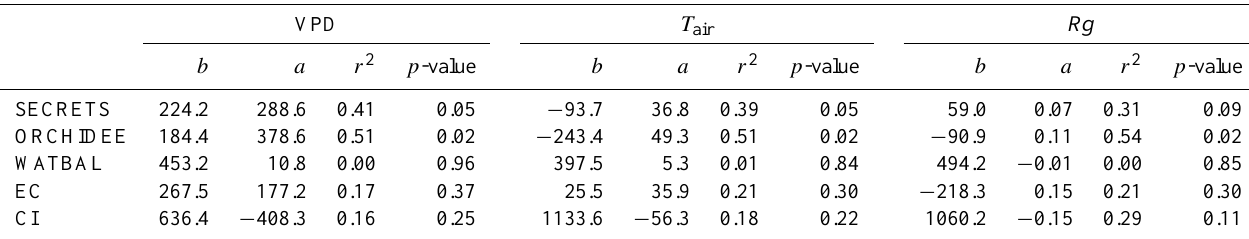
Table 4. Coefficients for the linear regression analyses between ET (based on annual totals) estimated by the five different approaches (SECRETS, ORCHIDEE, WATBAL, eddy covariance [EC], eddy covariance [EC], Conservative Ion (CI)) and the meteorological variables (i.e., mean yearly VPD; kPa, mean yearly air temperature [ T air ; Celsius] and yearly total global radiation [ Rg ; MJm − 2 a − 1 ]) for each of the five methods. In all cases the model used was: y ( x )= a * x + b . Included in the table are estimates of the coefficient of determination ( r 2 ) and the p -values for each regression